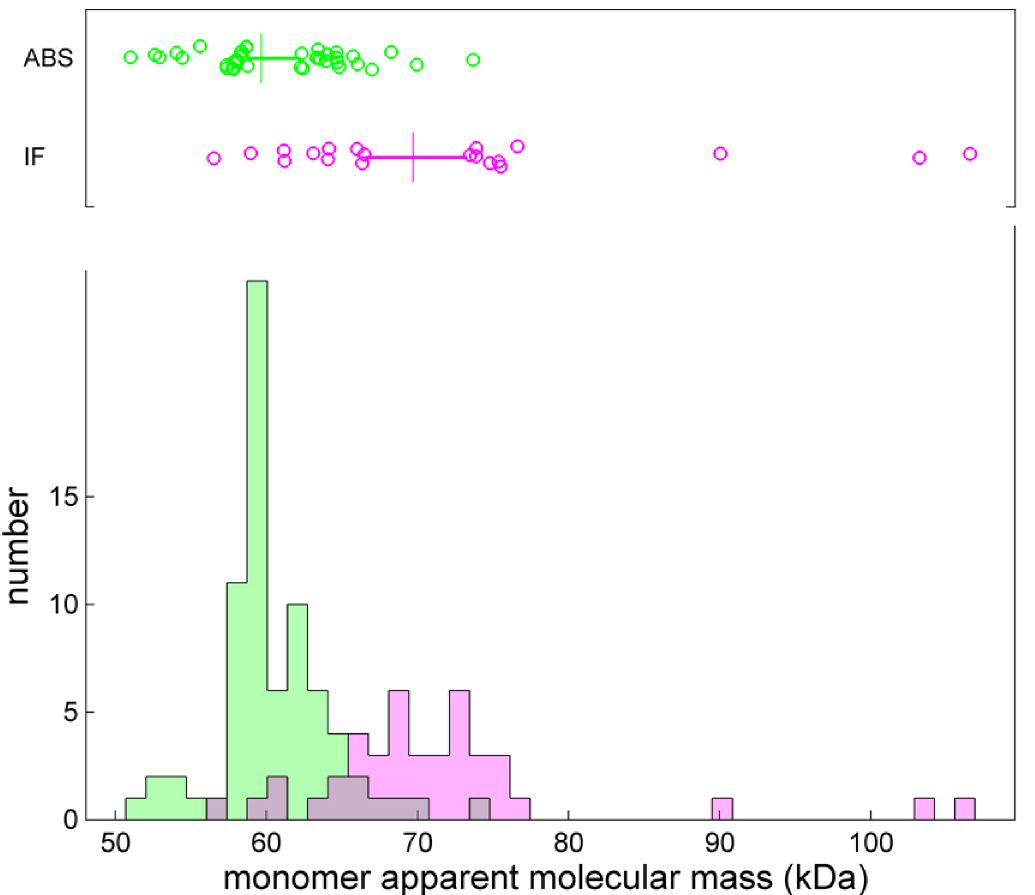
Fig 13. Corrected best-fit apparent monomer molecular mass from integration of the c ( s ) peak when scanned with the absorbance system (green) and the interference system (magenta). Only data with rmsd less than 0.01 OD or 0.01 fringes were included. The box-and-whisker plot indicates the central 50% of the data as solid line and draws the smaller and larger 25% percentiles as individual circles. The median is displayed as a vertical line.